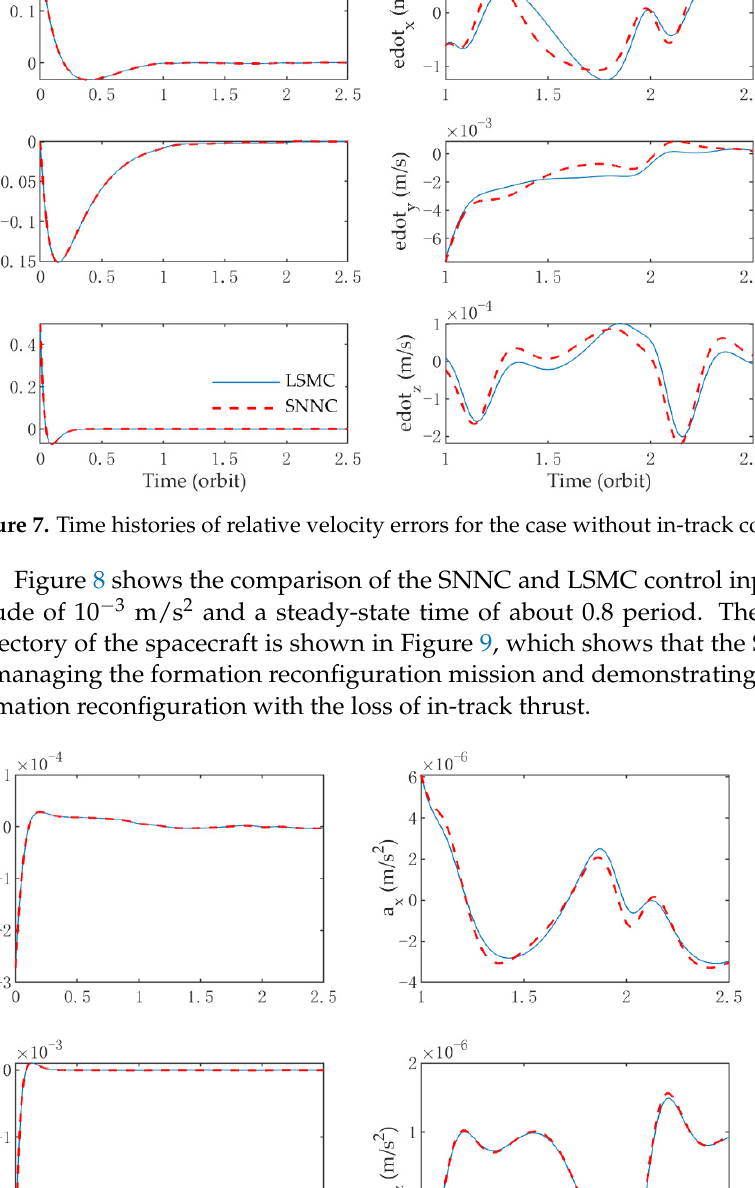
Figure 6. Time histories of relative position errors for the case without in-track control.